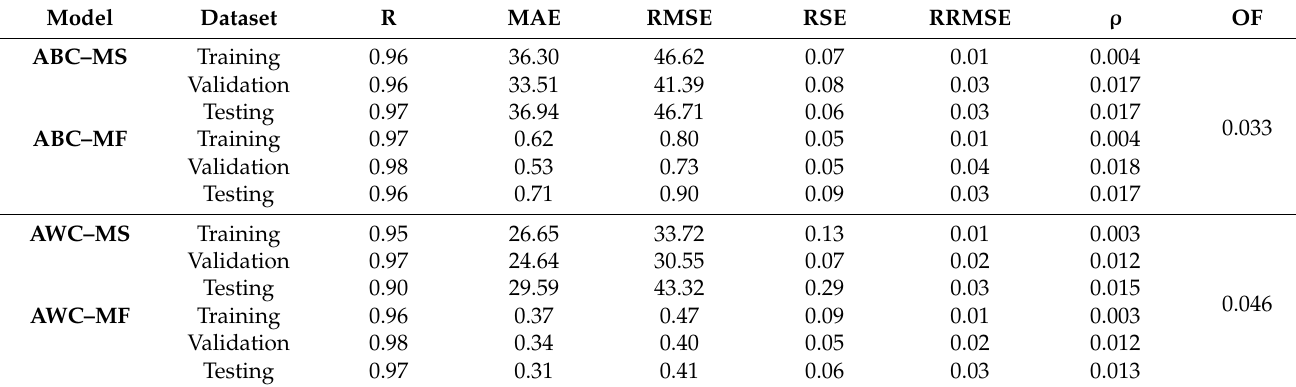
Table 7. Statistical measures for training, testing, and